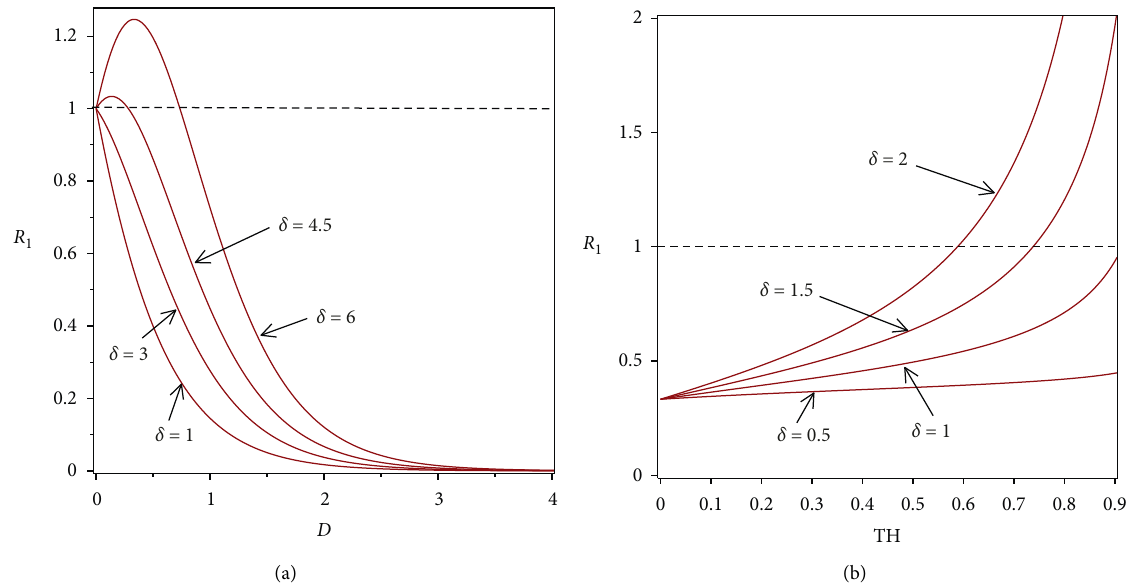
Figure 7: Effects of control parameters on the threshold condition R (b) D � 0 .